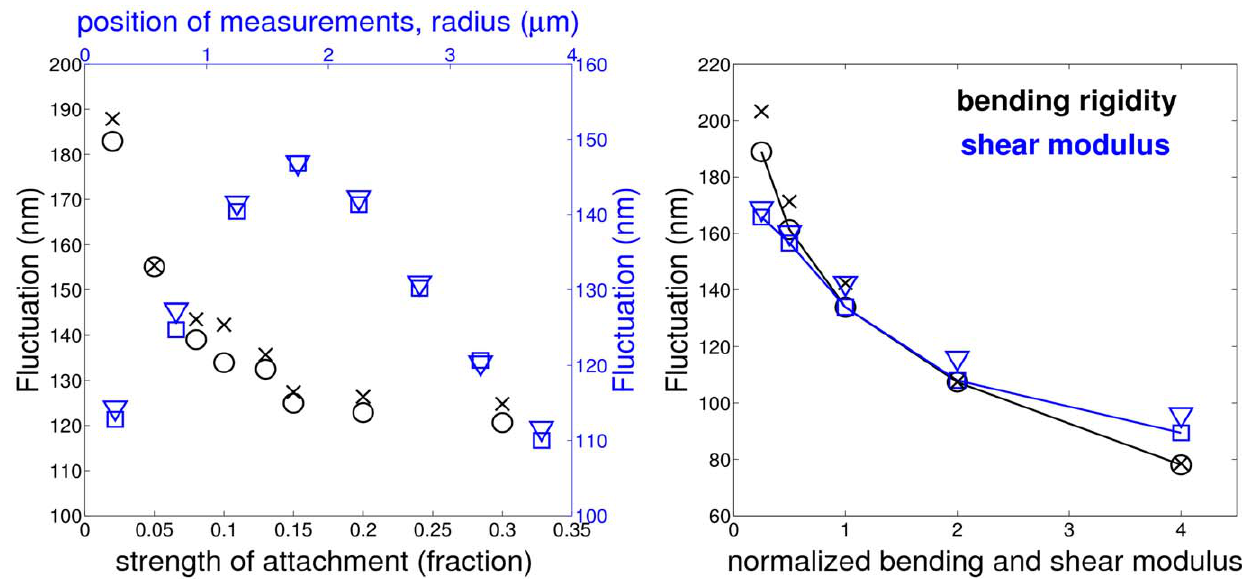
Figure 6. Sensitivity of membrane fluctuations. Sensitivity to the strength of attachment (vertex fraction) and the position of measurements (stripes of thickness 0 : 5 m m with different radii) (left). Dependence of fluctuations on the bending rigidity and the shear modulus normalized by healthy RBC values k c ~ 2 : 4 | 10 { 19 J and m 0 ~ 6 : 3 m N = m (right). T ~ 23 o C . Black circles and blue squares correspond to the full-width half-maximum (FWHM) values measured directly from the simulated distributions, while black crosses and blue triangles are the FWHM values obtained from the fitted Gaussian distributions to the calculated distributions. The membrane viscosity in all cases is assumed to be 0 : 022 Pa : s .